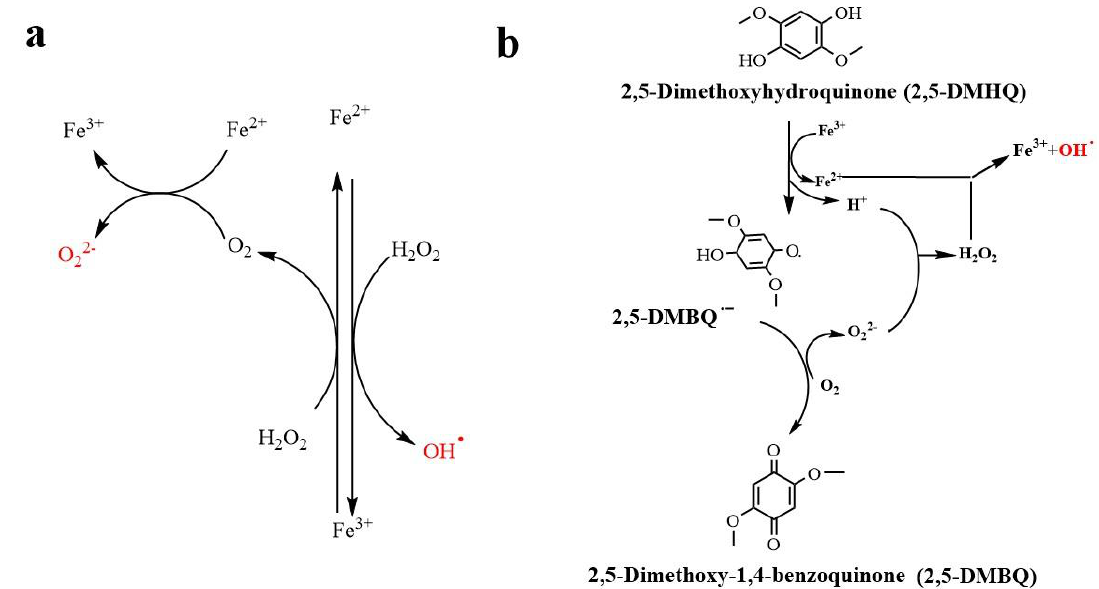
Figure 8. The mechanism of the Fenton reaction and its application. The hydroxyl radical (OH·) obtained from the Fenton reaction has a redox potential of more than 2.73 V, making it capable of directly attacking aromatic compounds [93] ( a ). The hydroxyl radical, which is capable of attacking lignin derivative 2,5-dimethoxyhydroquinone (2,5-DMHQ), is formed by the reduction of Fe 3+ and O 2 to Fe 2+ and H 2 O 2 with 2,5-dimethoxy-1,4-benzoquinone (2,5-DMBQ) [94,95] ( b ).